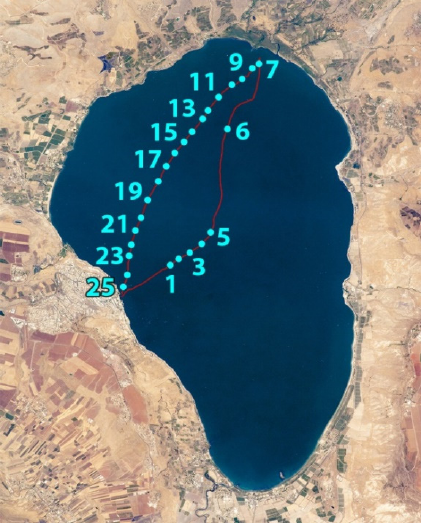
Figure 2. Map of Lake Kinneret with the track of the trimaran boat (red line) and spots where LiDAR sensing was carried out (cyan dots with ordinal numbers).